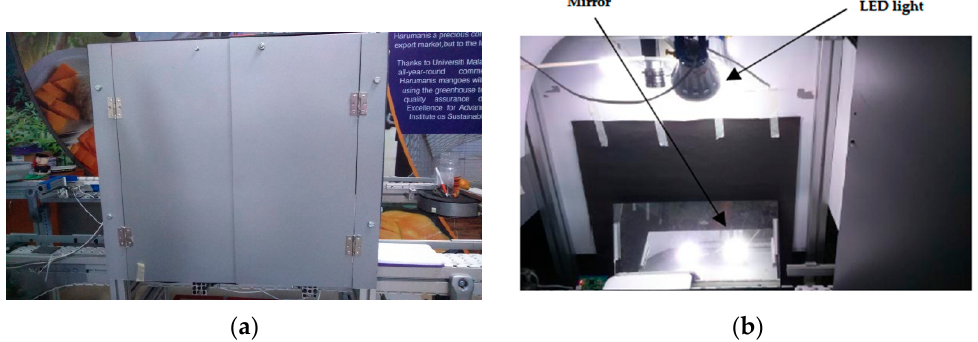
Figure 1. ( a ) Main frame of the image capturing platform; ( b ) Camera, light bulb and mirror setup inside the platform.